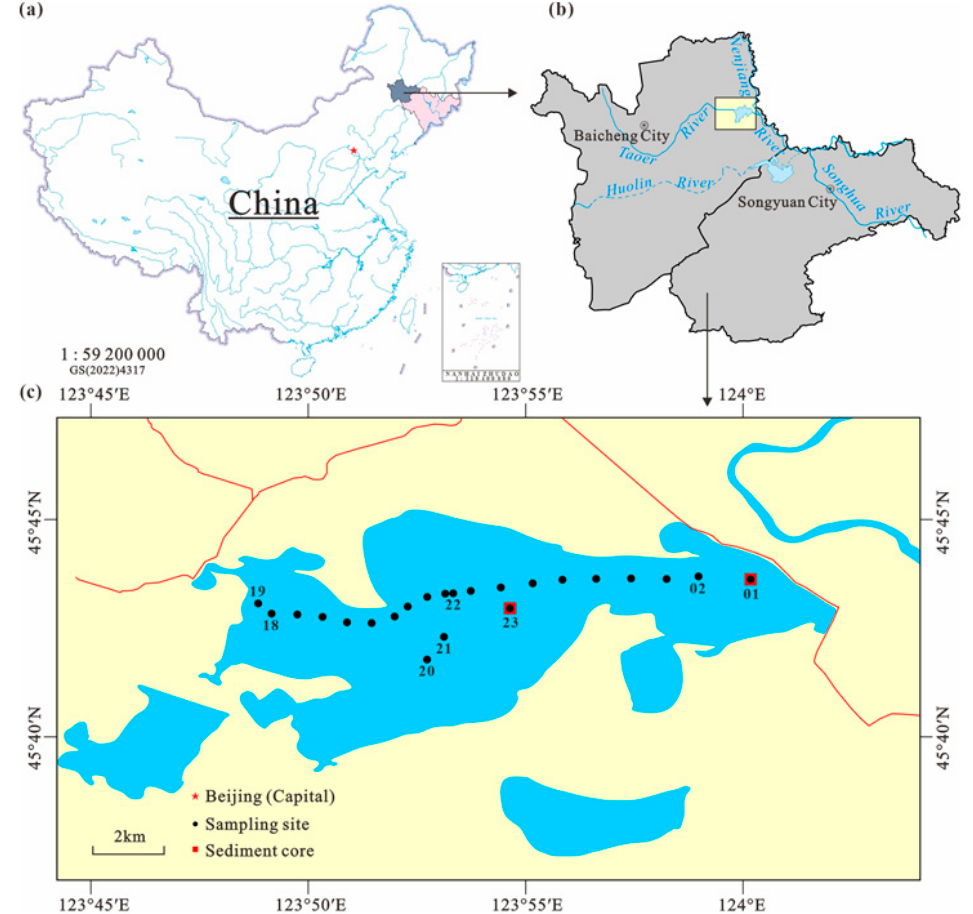
Figure 1. Geographic setting of Yueliang Lake ( a , b ) and detailed view of sampling sites ( c ).